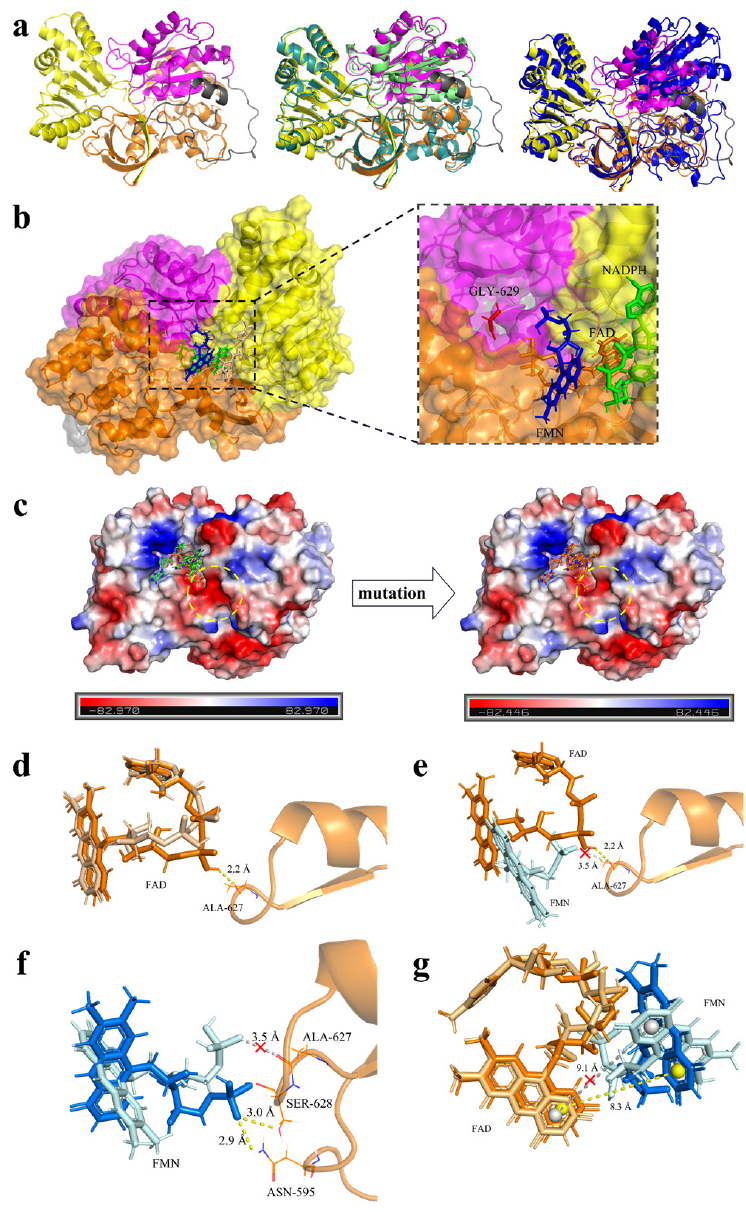
Figure 5. Molecular modeling and docking analysis of M1 and M3. ( a ) Homologous modeling was conducted for the reductase domain (NCP) of P450. From left to right: the homology modeling of NCP, the comparison results between NCP, 1bvy (PDB code: 1bvy [14], green) and 4dqk (PDB code: 4dqk [32], cyan), the comparison results between NCP and 1amo (PDB code: 1amo [33], blue). The structural domains of NCP are represented by different colors: the NAP domain in yellow, the FMN domain in magenta, the FAD domain in orange, the random coil in gray. ( b ) The docking results of M3 with FAD, NADPH and FMN molecules. The small molecules are represented by different colors: NADPH in green, FMN in blue, FAD in orange. G629 is represented by red. ( c ) Protein surface electrostatic potential display of M1 (left) and M3 (right). ( d – g ) Local display of docking results of FAD and FMN molecules with M1 and M3. FAD formed a new hydrogen bond with A627 ( d ) to replace the original long hydrogen bond ( e ). FMN forms new hydrogen bonds with N595 and S628, respectively ( f ). The distance between FMN and FAD was shortened ( g ). The small molecules of the M1 docking results are presented in light colors, and those of M3 are presented in dark colors. Hydrogen bonds at key positions of M1 and M3 are indicated by white dotted lines and yellow dotted lines, respectively. The red “x” indicates that these hydrogen bonds are broken in M3. Table 3. Substrate spectrum analysis of M3.